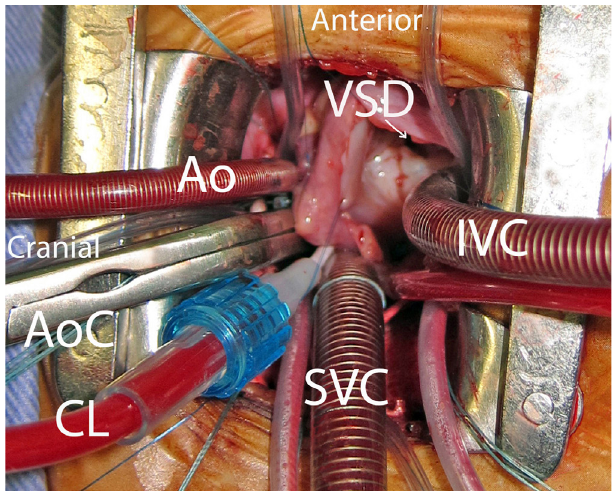
Fig. 1 - Operative surgical field aspect, with cannulas positioned in ascending aorta, superior and inferior vena cava. Aortic clamp and cardioplegic solution catheter positioned through the same incision. VSD approach through the right atriotomy. VSD: Ventricular septal defect, Ao: Aortic cannula, SVC: Superior vena cava cannula, IVC: Inferior vena cava cannula, AoC: Aortic clamp, CL: Cardioplegic